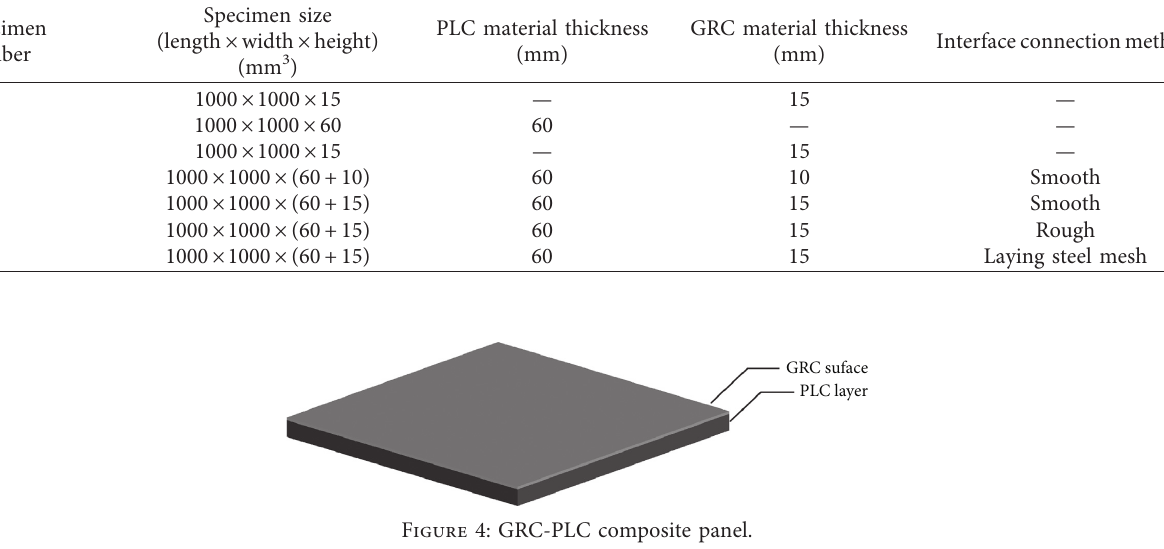
Table 5: Parameters of a new GRC-PLC composite panel.